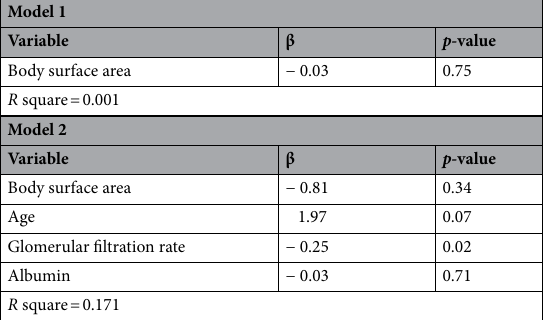
Table 2. Multivariable linear regression models including factors that are associated with PAM-Hb in breast cancer patients treated with cyclophosphamide. β standardized beta